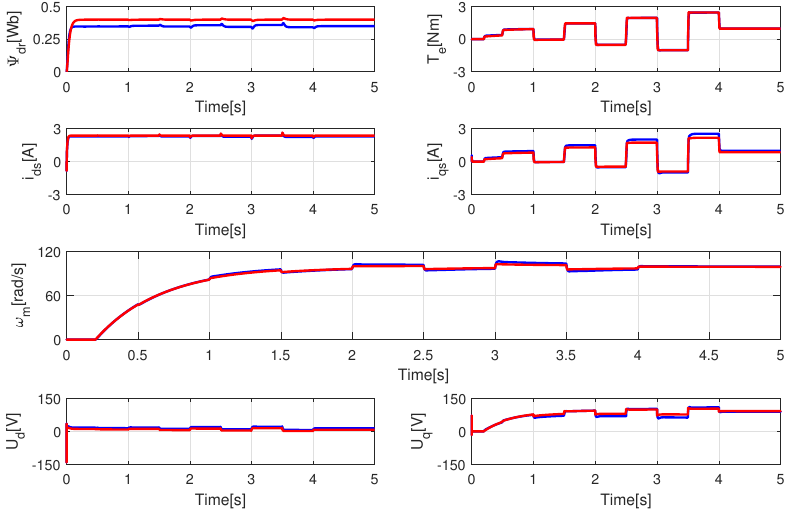
Figure 10. Case 1, parameter uncertainty test compared to ideal condition. Red curves with nominal parameters, blue ones with tuned.